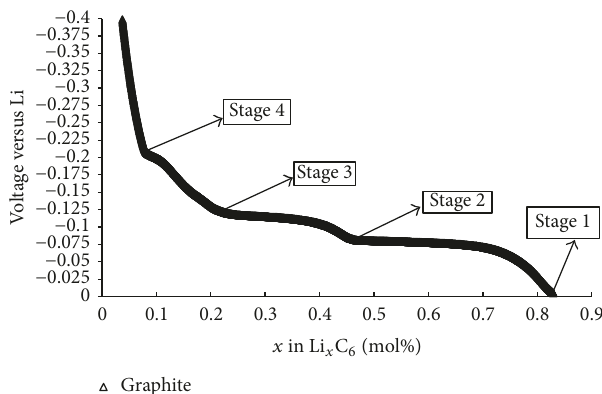
Figure 1: Four different stages in lithium intercalation in